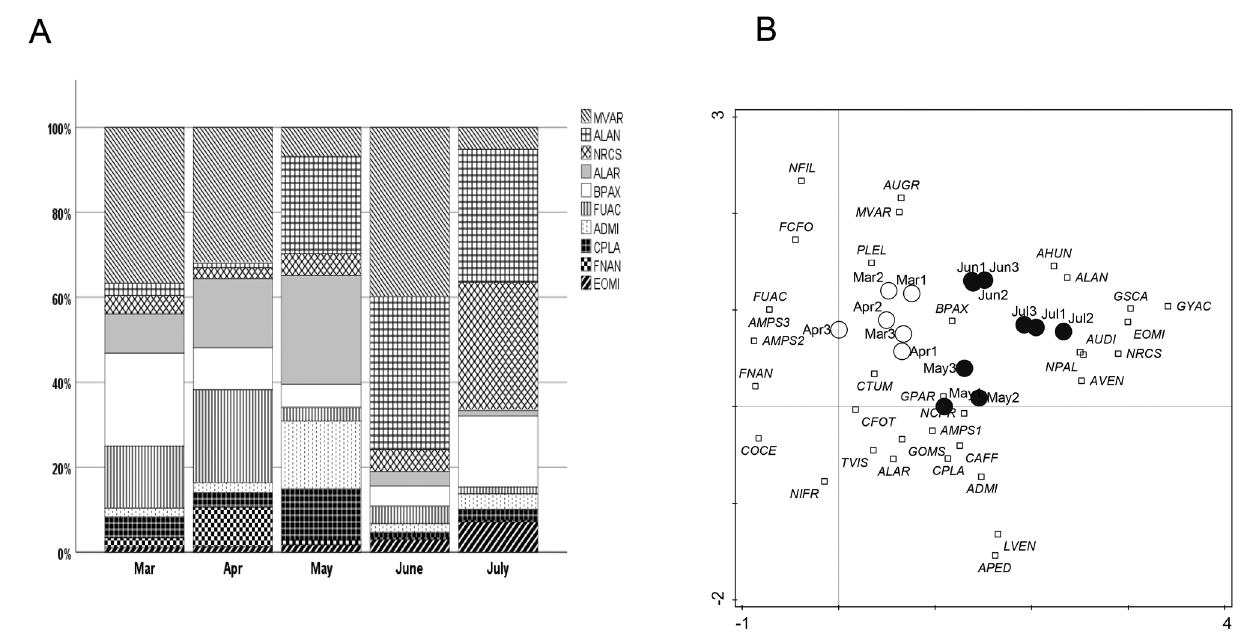
Figure 6 – Artificial substrate biofilm samples: A, relative abundance of the main diatom species (> 5% abundance); B, DCA of diatom assemblage (species > 1% relative abundance) with the samples from dry season (March–April; open circles) and wet season (May–July; closed circles). Eigenvalues are λ 0.3222 and λ 0.1121. Abbreviations for taxa are given in table 1 2